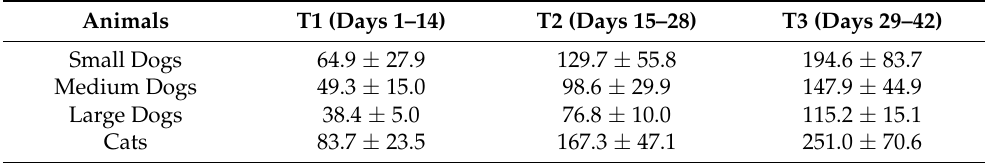
Table 1. Daily amount (mg/kg BW) of Spirulina administrated to small dogs ( n = 20), medium dogs ( n = 20), large dogs ( n = 20), and cats ( n = 30) during the 42 days of the trial; data are expressed as means ±